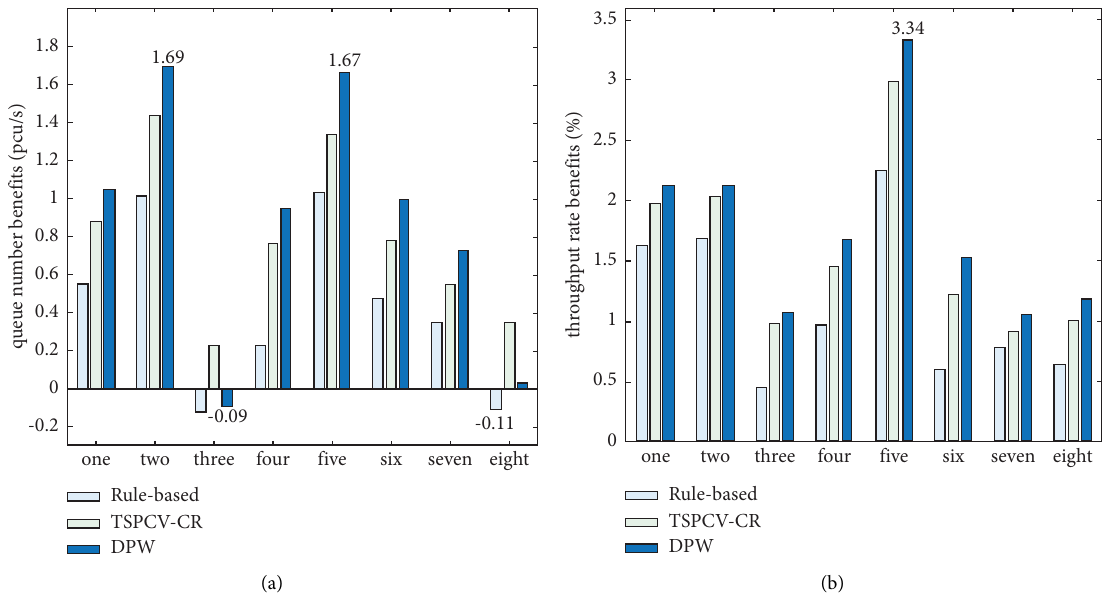
Figure 9: Performance benefts comparison between DPW-based and TSPCV-CR methods. (a) Queue number benefts. (b) Troughput rate